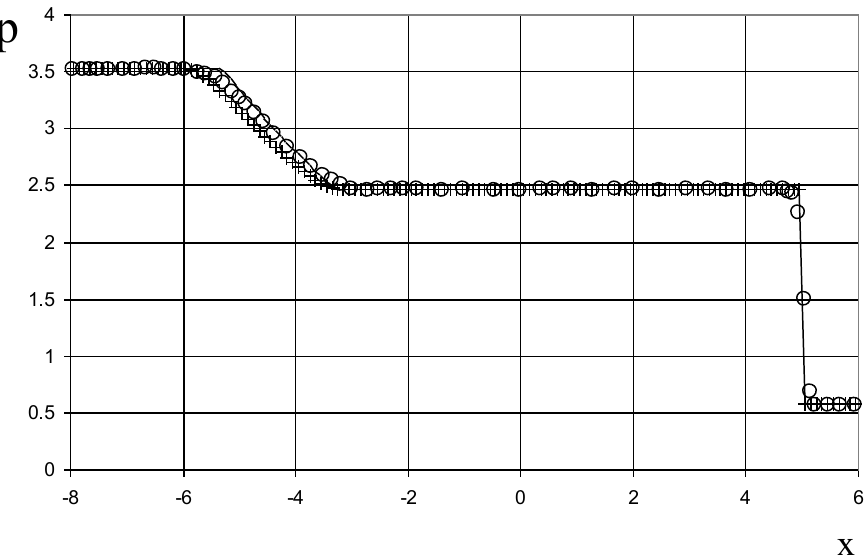
Figure 15. Velocity plot for the Riemann problem of Lax: the exact solution (line), the ULT1C scheme of Harten (circle), and the present method (cross).